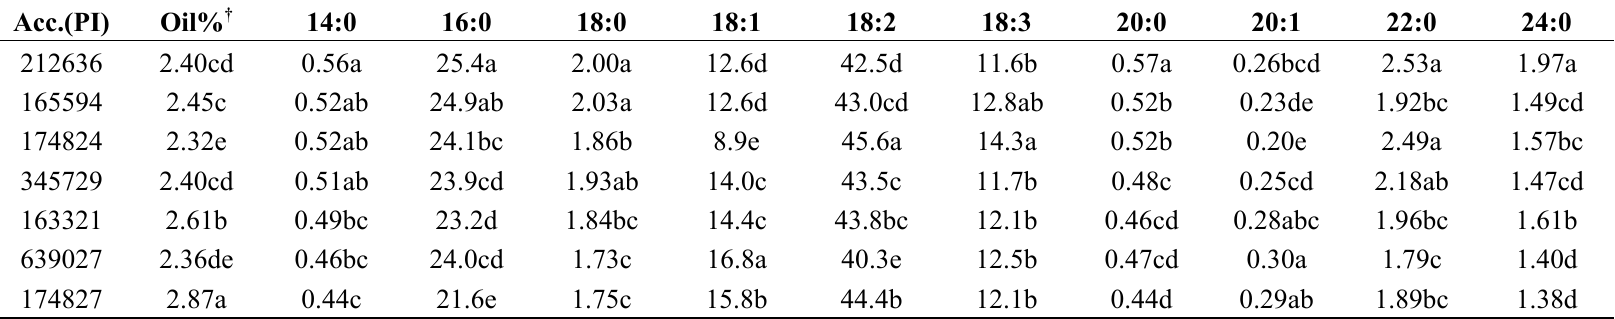
Table 2. Mean oil (% of DW) and fatty acid (% of total fatty acids) percentages among seven horse gram accessions grown in 2009 and 2010.